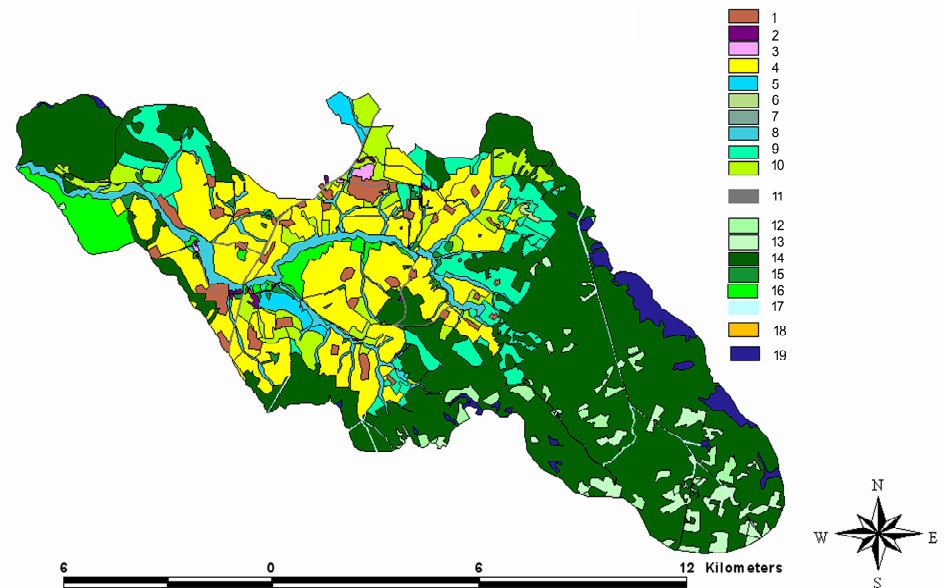
Figure 4. Land use units in the Zayachya river basin. 1 ‐ settlements, 2 ‐ industrial areas (saw ‐ milling